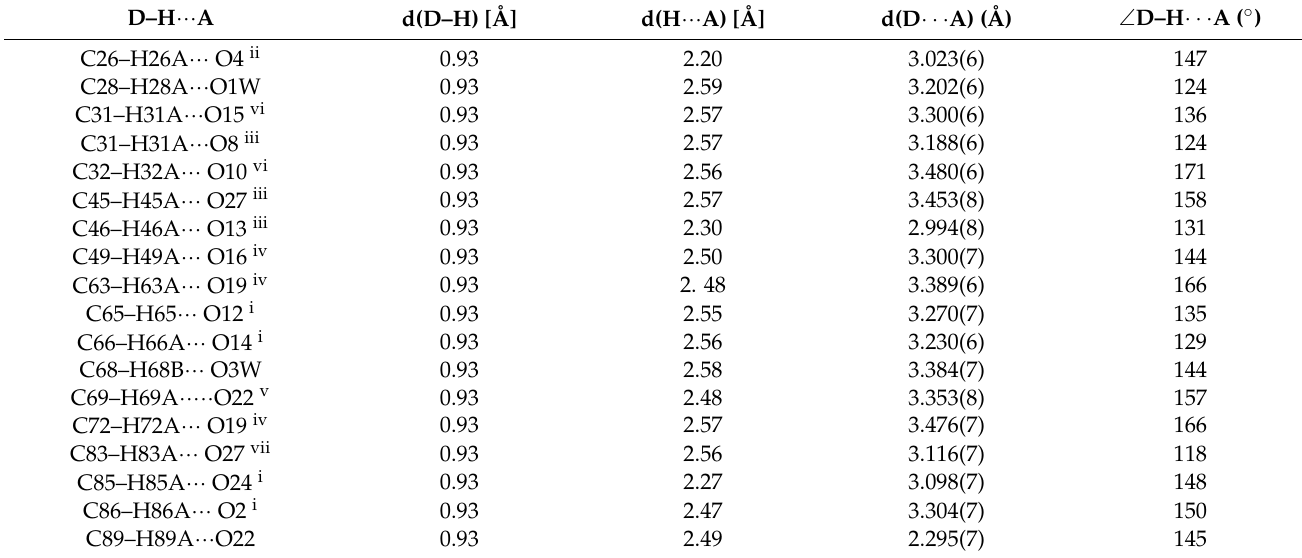
Figure 1. Molecular structure of title compound, showing the atom-labelling scheme.